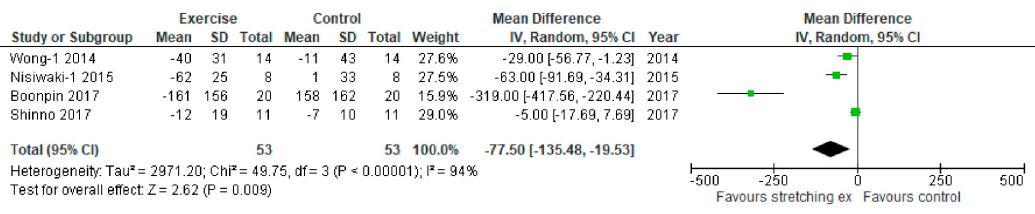
Figure 6 ． Sensitivity analysis-4 with only female subjects comparing changes in arterial stiffness following stretching exercises to non-exercise controls (sensitivity analysis-4 for primary outcome). IV, inverse variance; CI, confidence interval; Std, standardized.